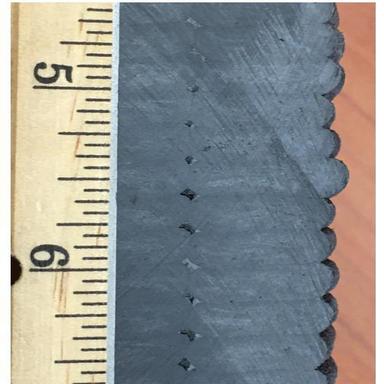
Illustration of macro-void formation during the AM process.